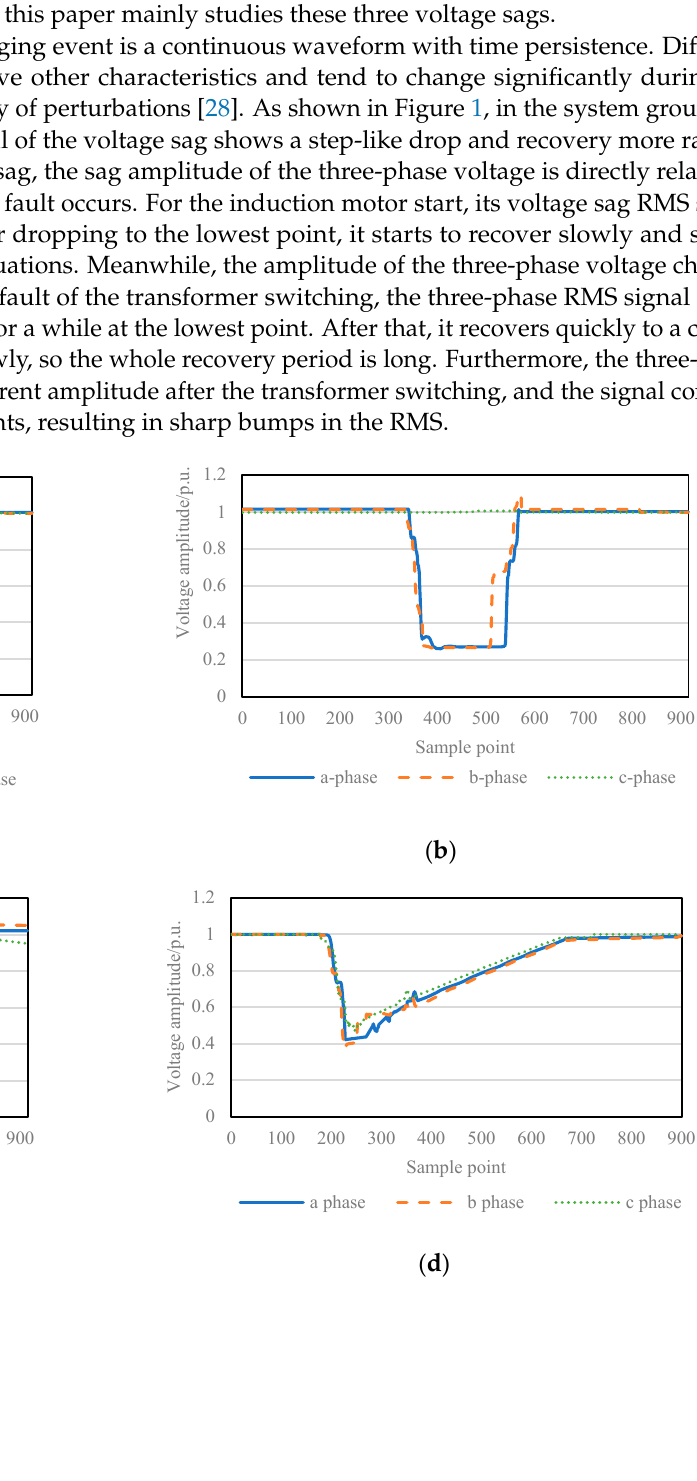
( e ) Figure 1. Comparison chart of different types of sag signals. ( a ) Voltage sag is caused by a single- phase grounding fault; ( b ) voltage sag is caused by a two-phase grounding fault; ( c ) voltage sag is caused by a three-phase grounding fault; ( d ) voltage sag is caused by induction motor starting; ( e ) voltage sag is caused by transformer switching. In summary, each type of temporary drop in RMS signal has distinct variation char- acteristics. This paper calls the original provisional drop recording data with large dimen- sions a high-dimensional sample, affected by noise factors such as power grid conditions, and the same kind of features have instability in the original feature space. In contrast, the larger dimension leads to increased training complexity, which is not conducive to effi- cient identification. Deep learning can extract more effective depth characteristics of high- dimensional samples to give the model better generalization ability. 3. Implementation of the Model The structure diagram of the integrating SAE and AttUnet is shown in Figure 2. SAE is a symmetric, unsupervised 3-layer neural network that contains encoders and decoders. The encoder can map high-dimensional feature spaces to low-dimensional implicit layer vector spaces to reduce feature dimensionality. The decoder reverses the implicit layer vector space to the output layer features and implements feature reconstruction to fit the nonlinear coupling relationship between the input layer data of the sample staging signal and the reconstructed output layer data. SAE adds sparse constraint terms to the loss function, improves feature learning ability [29], and obtains a more efficient low-dimen- sional representation of high-dimensional staging features in the implicit layer. The low- dimensional data enter AttUnet for further feature extraction. AttUnet is a symmetrical U-shaped full-scale convolutional neural network that introduces a contextual attention mechanism. Consisting of symmetrical encoders and decoders and jump connections con- necting low-level features with higher-level features, it is possible to learn elements of